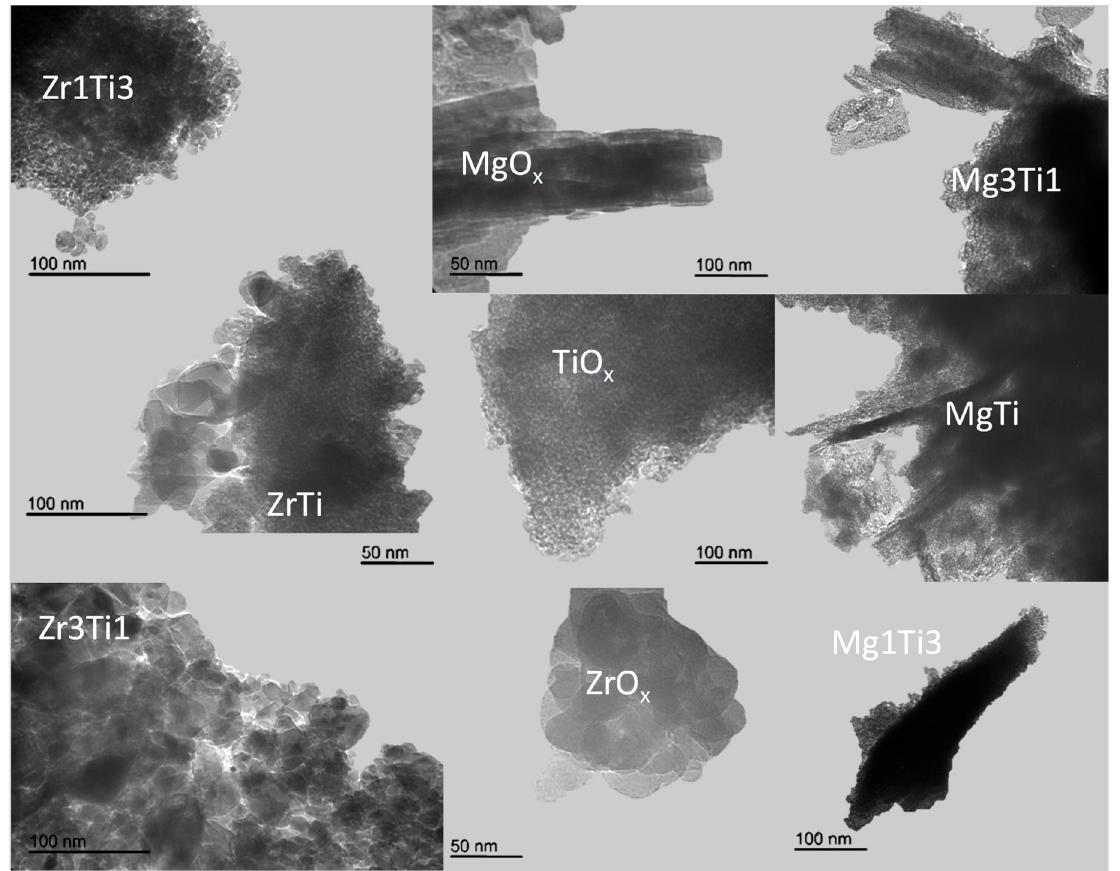
Figure 4. Transmission electron microscopy (TEM) images of the different solids.